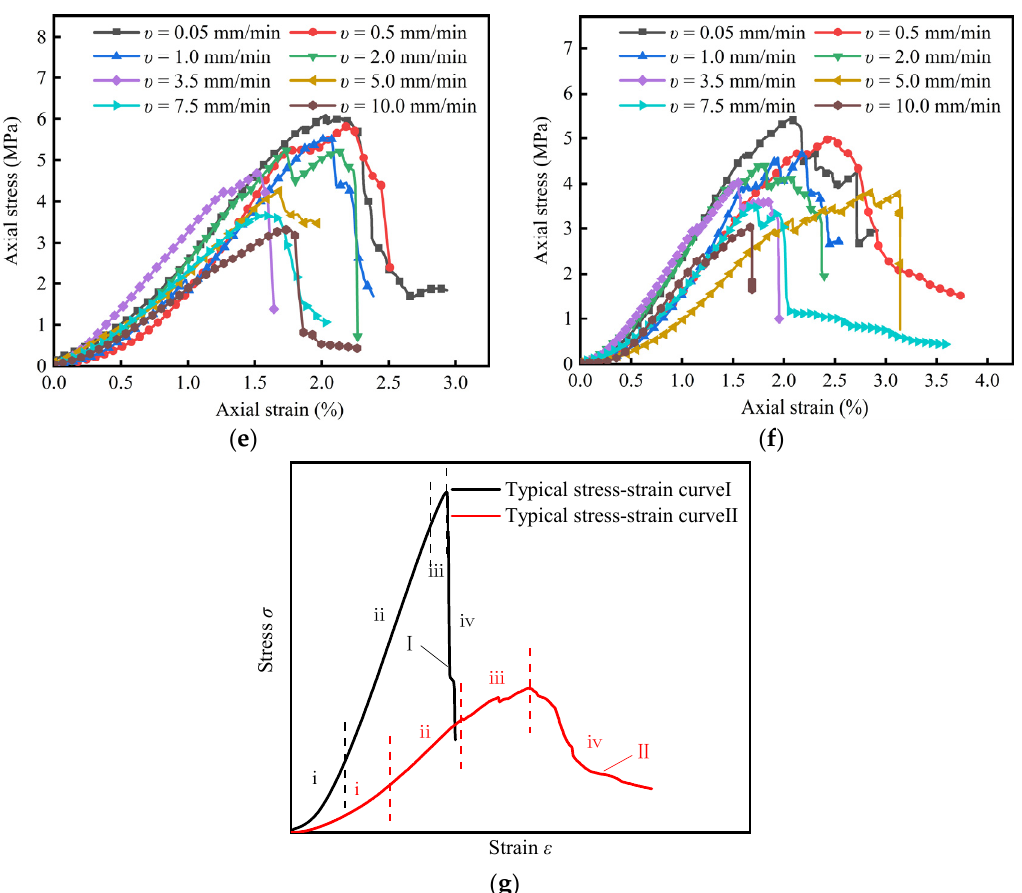
Figure 6. Axial stress–strain curves of coal samples under di ff erent loading rates and inclination angles: ( a ) θ = 0 ◦ ; ( b ) θ = 5 ◦ ; ( c ) θ = 10 ◦ ; ( d ) θ = 15 ◦ ; ( e ) θ = 20 ◦ ; ( f ) θ = 25 ◦ ; ( g ) typical axial stress–strain curves of coal